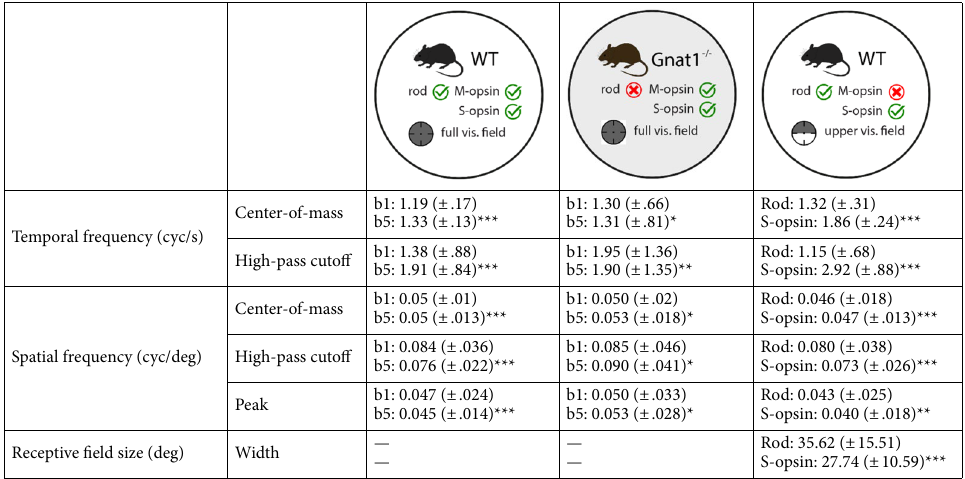
Table 1. Summary of spatio-temporal tuning estimates, outlining parameter mean and standard deviation values from Figs. 5, 6 and 7. Parameter estimates for temporal frequency, spatial frequency, and receptive field size mapping experiments from Figs. 5, 6 and 7, respectively, compiled in table format. First 2 rows outline temporal frequency curve fit parameter estimates of center-of-mass and high-pass cutoff for “b1” (12 K R*/rod/sec) vs. “b5” (187 K R*/rod/sec) conditions in wild-type mice (3rd column), “b1” vs. “b5” in rodless (Gnat1 −/− ) mice (4th column), and “b5” cone vs. rod inputs in wild-type mice (5th column). “Rod” and “S-opsin” in last (5th) column indicate M-opsin contrast and S-opsin contrast stimuli used, respectively. Next 3 rows outline spatial frequency curve fit parameter estimates of center-of-mass, high-pass cutoff, and peak for “b1” vs. “b5” conditions in wild-type mice (3rd column), “b1” vs. “b5” but in rodless (Gnat1 −/− ) mice (4th column), and “b5” cone vs. rod inputs in wild-type mice (5th column). Last row outlines receptive field size comparison, measured as 2σ of Gaussian fit, between “b5” rod vs. cone inputs in wild-type mice. For each measurement listed, “ mu (± std )” format is used to denote geometric mean value followed by standard deviation for temporal-spatial frequency parameters. “ mu (± std )” format is used to denote arithmetic mean value followed by standard deviation for receptive field size estimates. “*/**/***” state statistical significance of p-values under .05, .01, and .001,